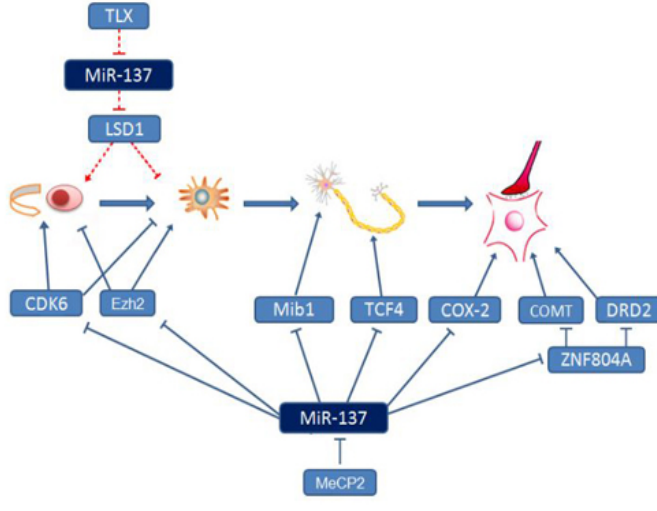
Figure 2. The role of gene regulatory networks of miR-137 in neurogenesis and maturation. Inhibitory effect found in embryos: , stimulatory effect found in embryos: , Inhibitory effect found in adults: , stimulatory effect found in adults: